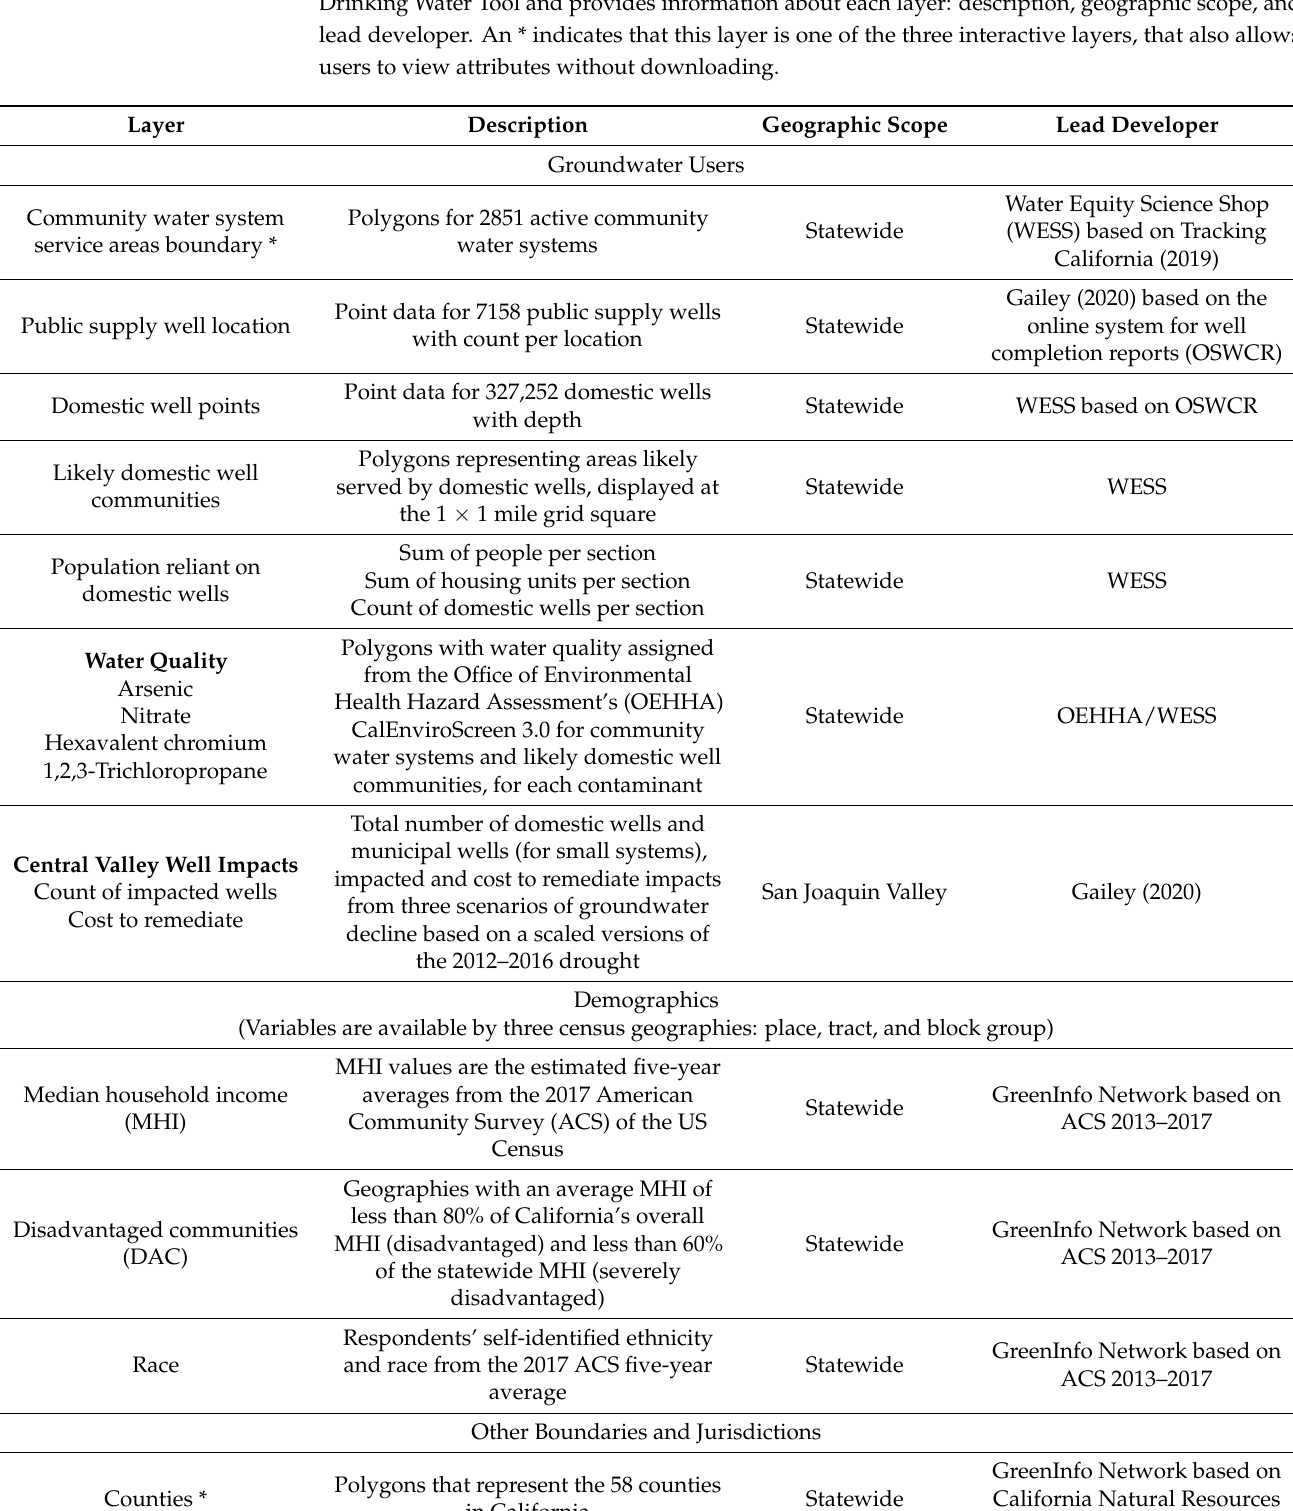
Table A1. Drinking Water Tool Layers. This table lists all the reference data layers available in the Drinking Water Tool and provides information about each layer: description, geographic scope, and lead developer. An * indicates that this layer is one of the three interactive layers, that also allows users to view attributes without